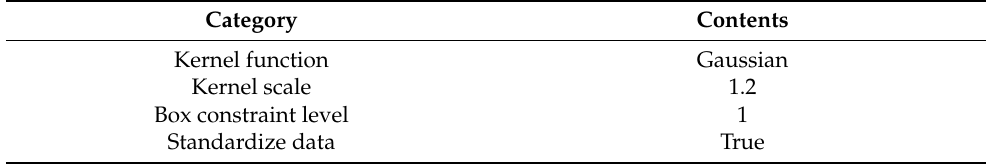
Table 5. Parameter configuration of SVM model.